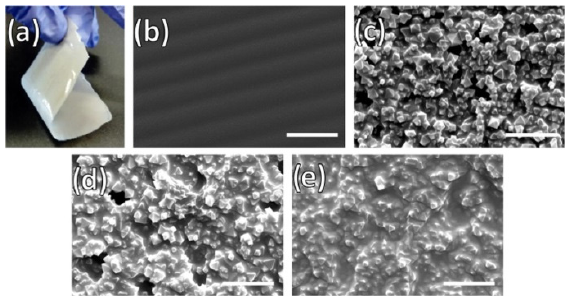
Figure 17. ( a ) Photograph of free-standing 50 wt % MOF-loaded UiO-66-allyl-C MMM. ( b − e ) SEM images (top side) of MMMs: ( b ) PDMS-only membrane, ( c ) UiO-66-allyl MMM, ( d ) UiO-66-allyl + PDMS MMM, and ( e ) UiO-66-allyl-C MMM. All MOF-containing MMMs are at 50 wt %. Scale bars are 2 µ m. Reprinted with permission from [118], Copyright (2019) American Chemical Society.